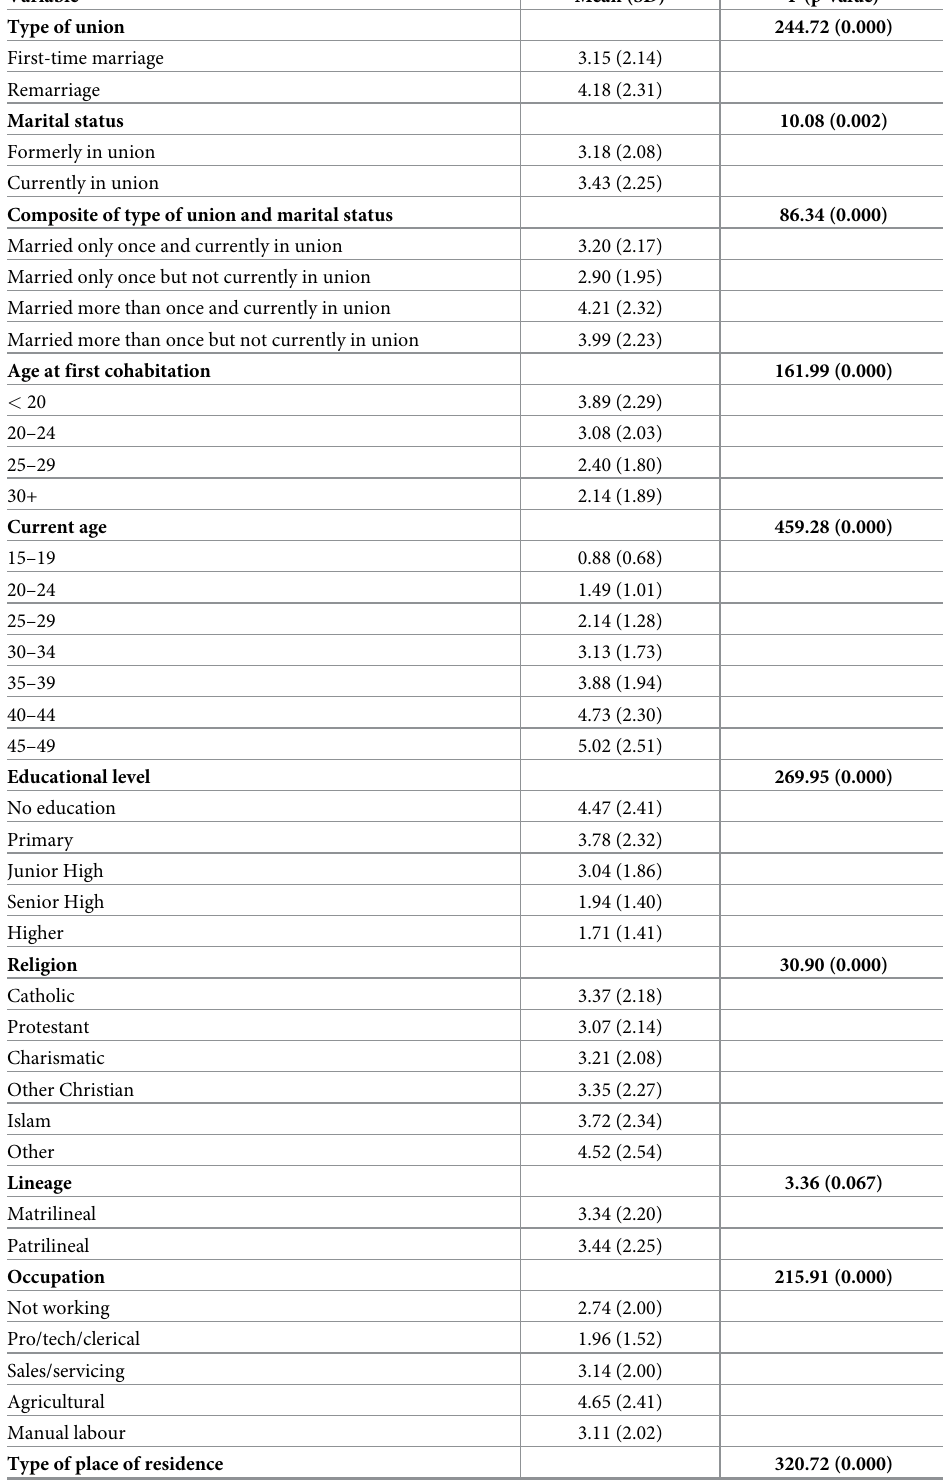
Table 2. Mean number of children ever born by background characteristics of